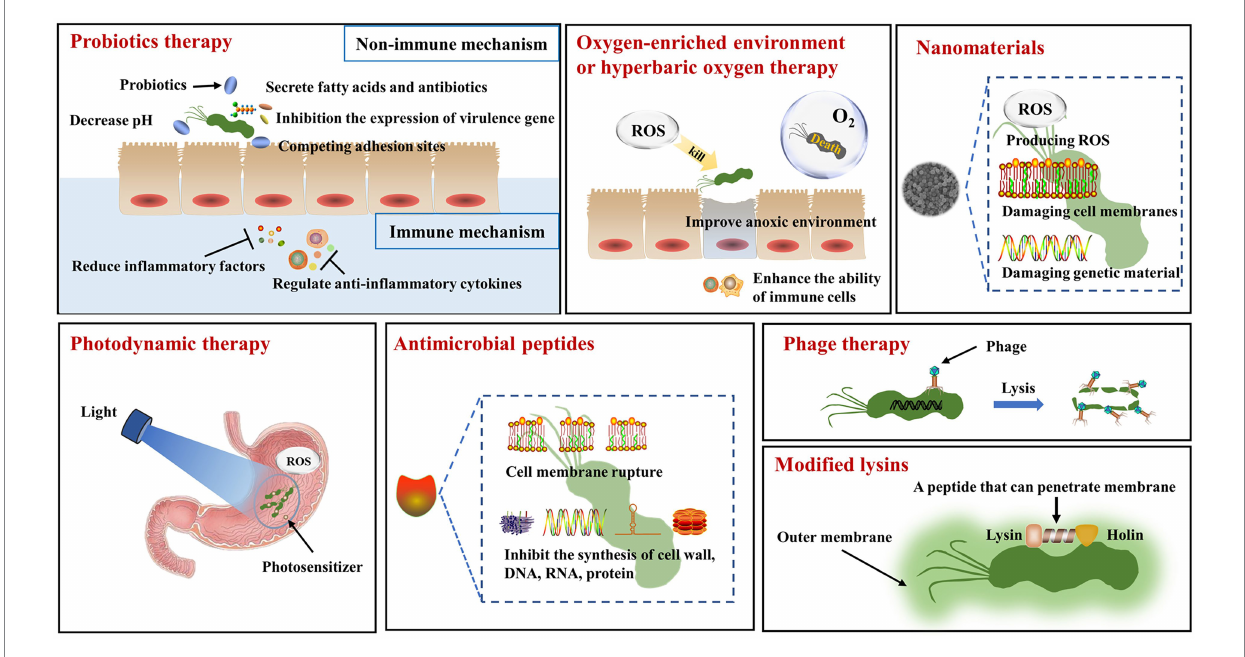
FIGURE 1 The mechanisms of non-pharmacological therapy for Helicobacter pylori . Probiotics therapy: In the non-immune mechanism, probiotics can secrete fatty acids and antibiotics to act on H. pylori , inhibit the expression of virulence gene in H. pylori , and compete for the adhesion sites of H. pylori . In the immune mechanism, probiotics can reduce the release of inflammatory factors and regulate the secretion of anti-inflammatory factors. Oxygen- enriched environment or hyperbaric oxygen treatment: Oxygen-rich environment makes it impossible for H. pylori to survive. Hyperbaric oxygen therapy produces reactive oxygen species that act on H. pylori , improving the hypoxic environment and increasing the phagocytic capacity of immune cells. Nanomaterials: Nanomaterials can generate reactive oxygen species and destroy the cell membrane and genetic material of H. pylori . Photodynamic therapy: The combination of light source and photosensitizer can kill H. pylori by producing reactive oxygen species. Antimicrobial peptides: Antimicrobial peptides can disrupt cell membranes and inhibit the synthesis of cell walls, DNA, RNA and proteins. Phage therapy: Phage specifically acts on H. pylori to make it lyse. Modified lysins: The genetically engineered lysins can penetrate the outer membrane of H. pylori and interact with it.